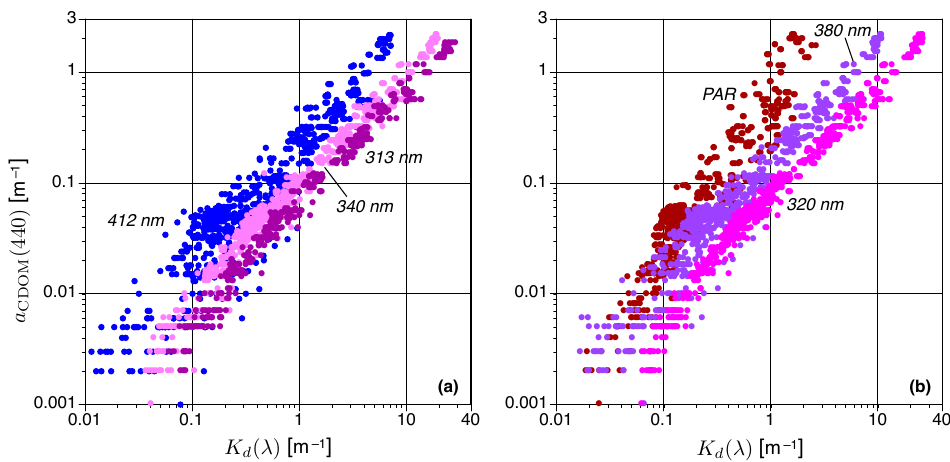
Figure 3. The in situ observations for the one-band C-OPS K d ( λ ) algorithms to derive a CDOM ( 440 ) with the spectral bands chosen to emphasize both a next-generation (UV) and legacy (blue domain) perspective: ( a ) the data for 313, 340, and 412nm (left panel), and ( b ) the data for 320 and 380nm plus PAR (right panel).